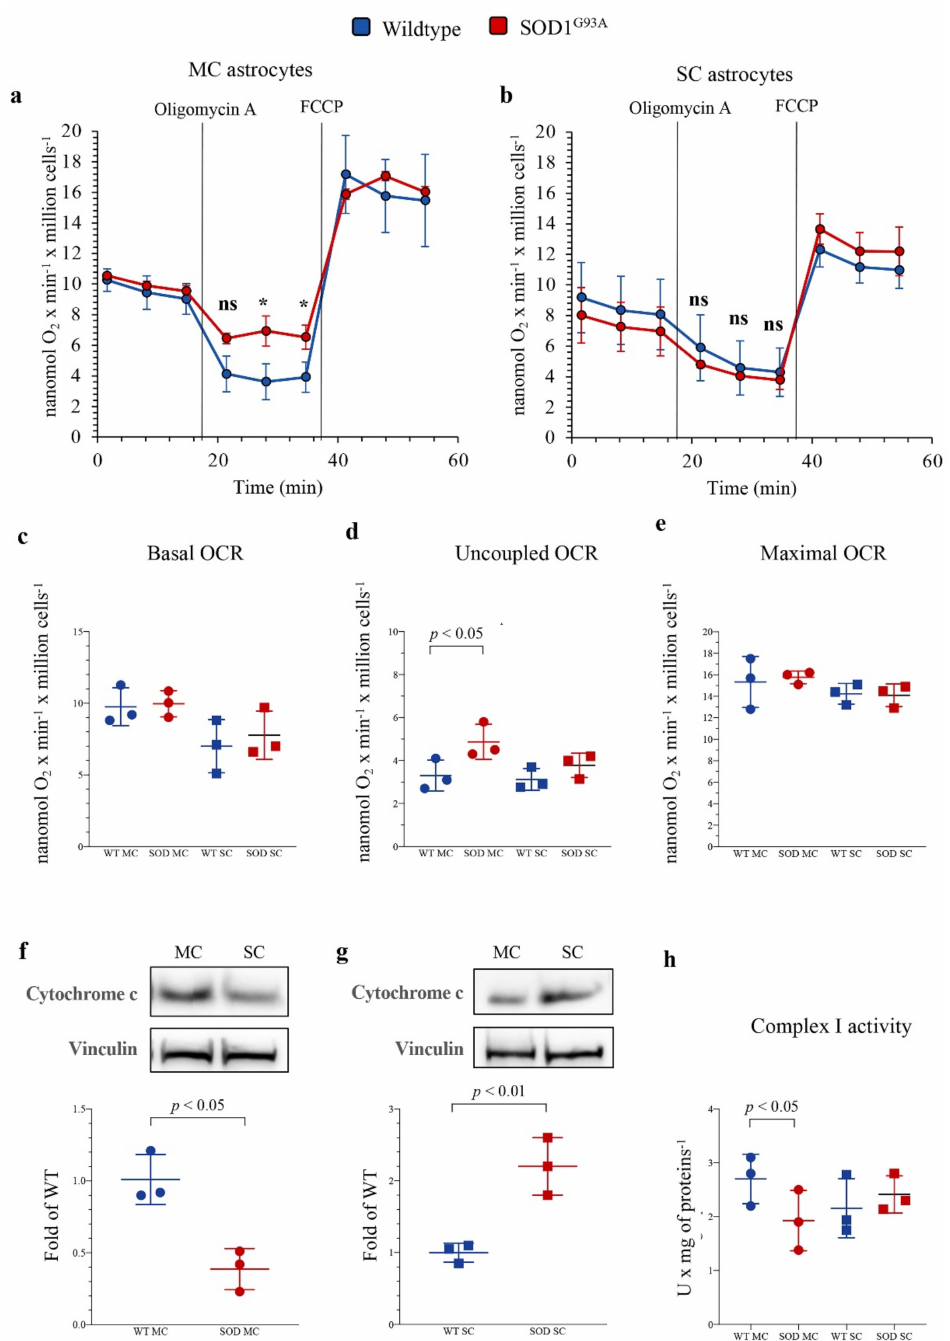
Figure 3. Mitochondrial energetic function in SOD1 G93A astrocytes. Basal oxygen consumption rate (OCR) measured in presence of glucose (11 mM), glutamine (2 mM) and pyruvate (1 mM) and after sequential injection of the ATP-synthase inhibitor oligomycin A (1 mM) and the ATP synthesis uncoupler FCCP (0.8 µ M) in ( a ) motor cortex (MC) and ( b ) spinal cord (SC) astrocytes, in wildtype (blue) and SOD1 G93A astrocytes (red). ( c ) Basal, ( d ) uncoupled and ( e ) maximal OCRs in wildtype (blue) and SOD1 G93A (red) astrocytes harvested from MC and SC. Western blot analysis and relative densitometric quantitative analyses of cytochrome c in MC ( f ) and SC ( g ) astrocytes. ( h ) Complex I activity in wildtype (blue) and SOD1 G93A (red) astrocytes harvested from MC and SC. Data are shown as the mean ± SD. n = 3 experiments per group, with each value defined in triplicate. ns = not significant, * = p < 0.05 vs. corresponding WT